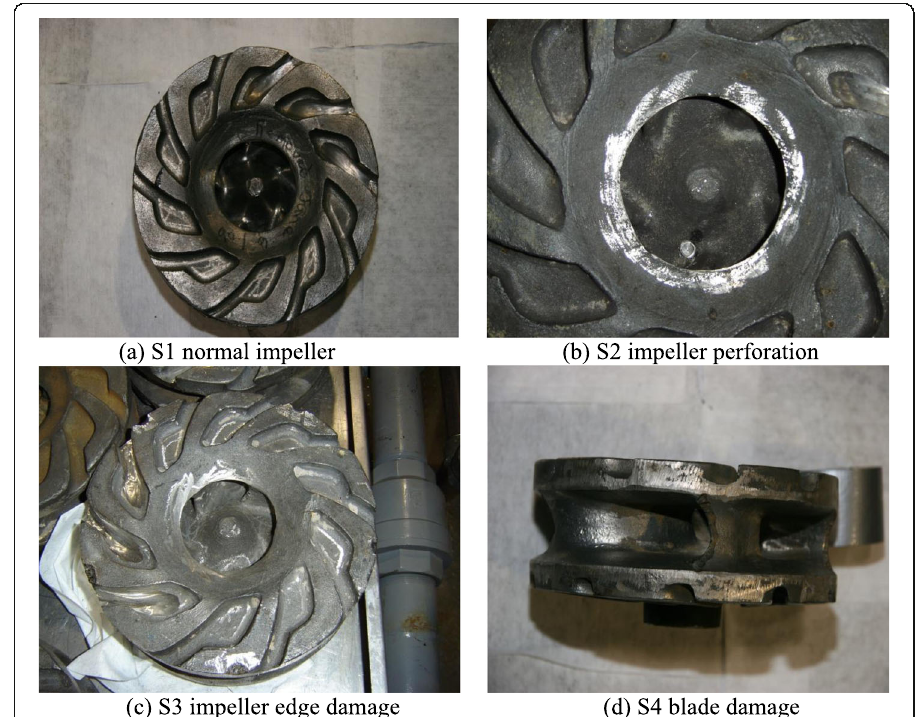
Fig. 13 Four failure modes of the impeller in the experiment. a S1 normal impeller. b S2 impeller perforation. c S3 impeller edge damage. d S4 blade